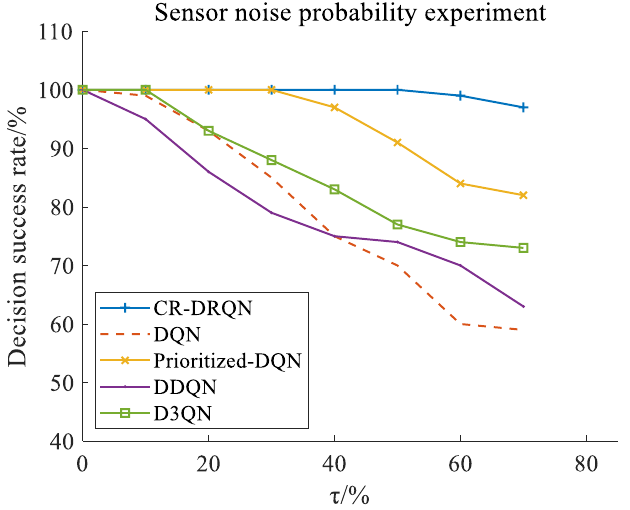
Figure 5. Decision success rate under different probabilities of noise occurrence.